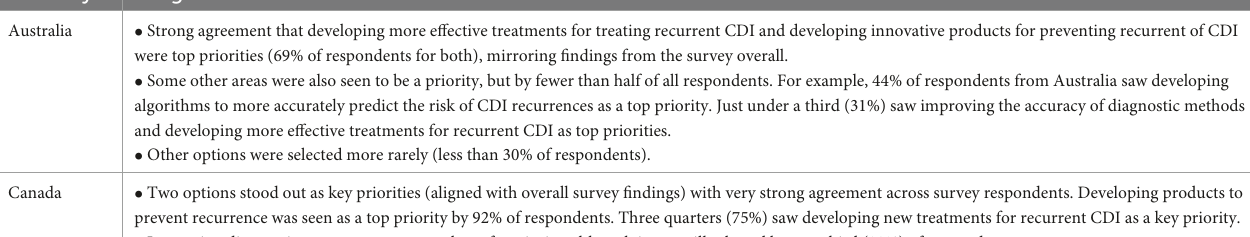
TABLE 4 Country-level insights relating to diagnosis and treatment priorities.